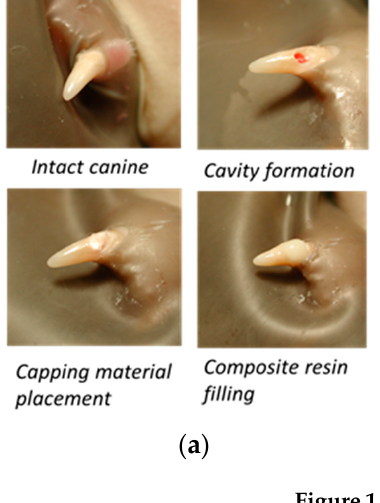
Figure 1. ( a ) The experimental procedures of pulp capping and coverage. ( b ) Diagram of the prepared cavity and capping materials. The pulp exposure site was covered by a capping material (Dycal, a blank collagen membrane, or a membrane containing PP or DSP/PP), followed by a Teflon disk, a thin layer of glass ionomer (GIC), and a resin composite. Table 1. The scoring system used to evaluate the pulp response to direct pulp capping [39,40].